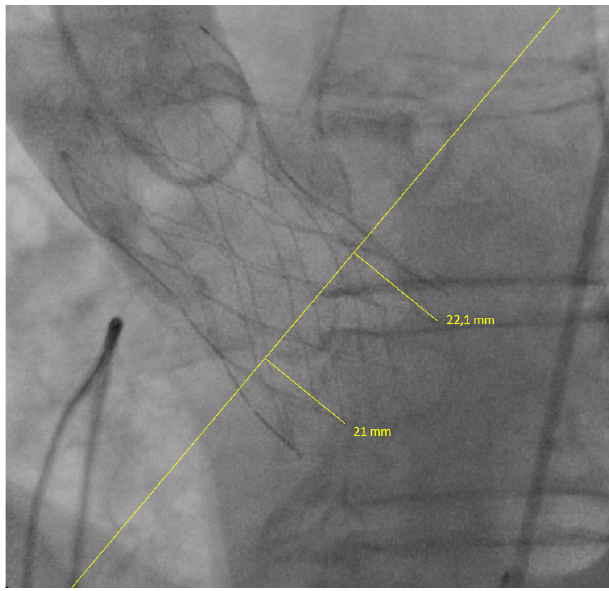
Fig. 1 - Postoperative aortogram (LAO 12.2°, CRAN 10.1°) with depth implantation metrics for non-coronary and left coronary